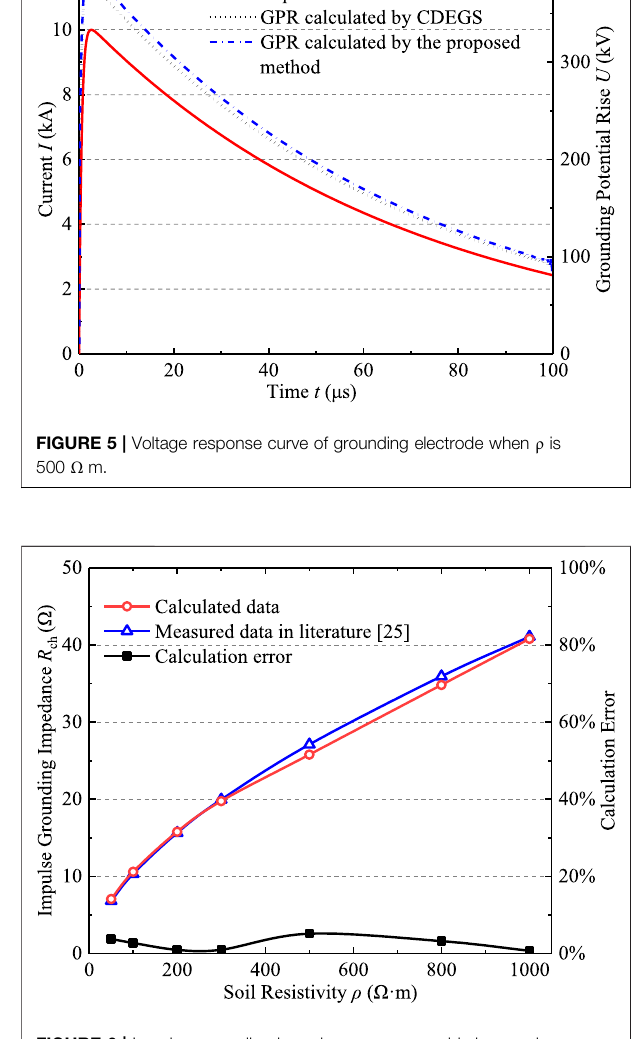
FIGURE 6 | Impulse grounding impedance curve considering spark discharge